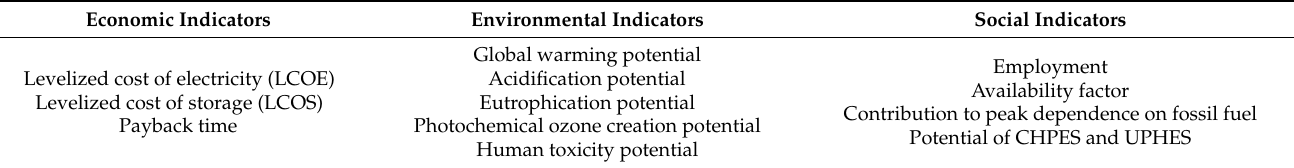
Table 5. Sustainability indicators used in LCSA of “pumped hydro energy storage” [52].